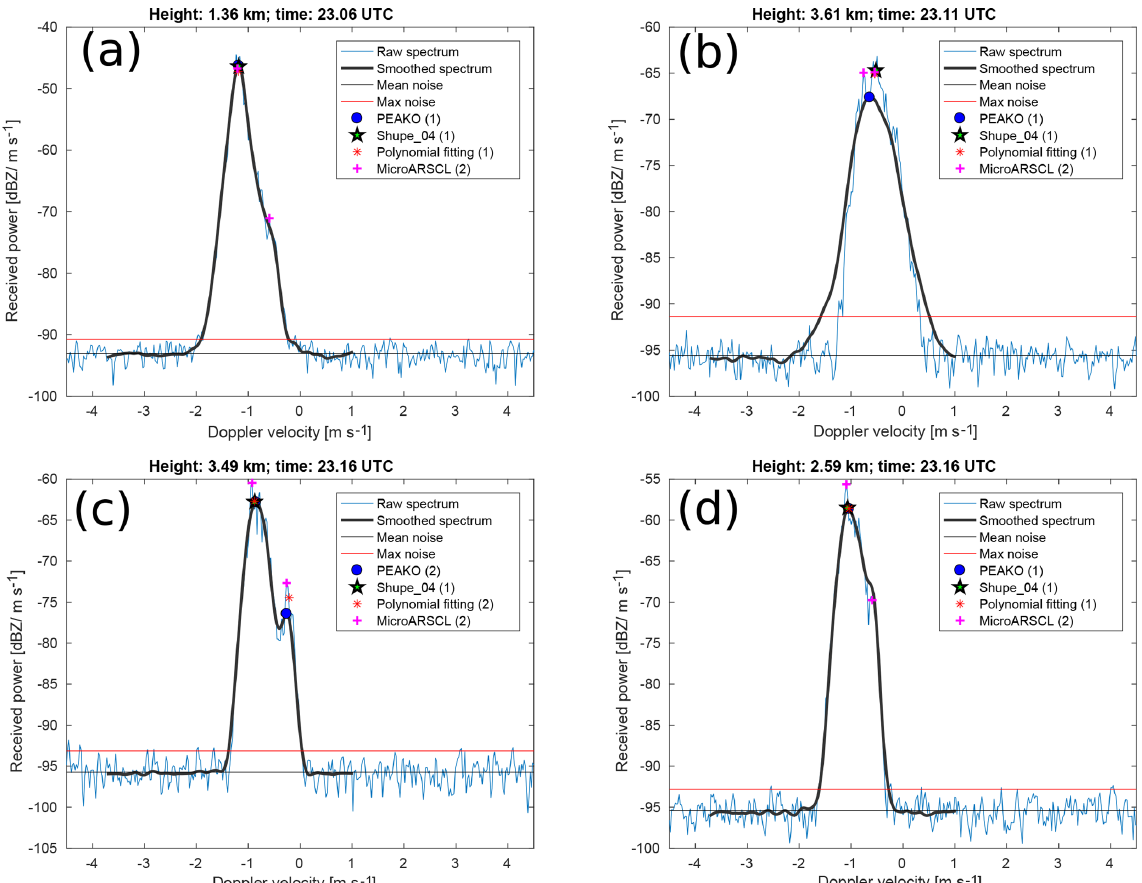
Figure B4. Three example spectra selected from the case study on 21 February 2014, 23.01–23.25UTC. Please note that the y axis scale is different for each of the spectrum